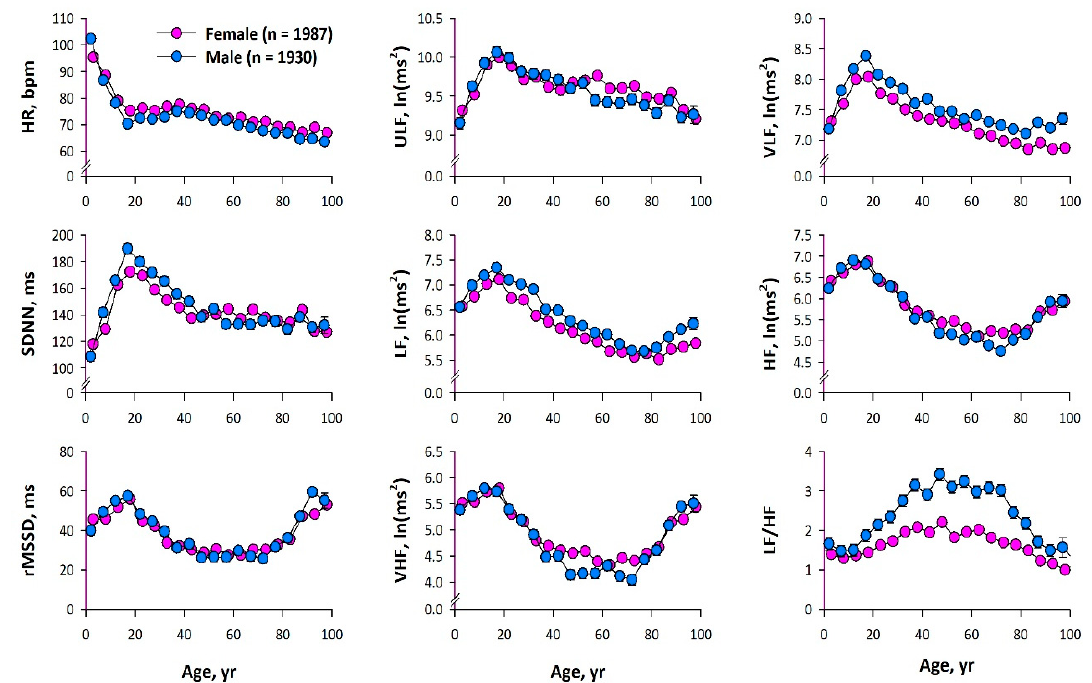
Figure 6. Age and sex dependency of the metrics of heart rate variability (HRV). HR = 24-h mean heart rate, SDNN = standard deviation of 24-h normal-to-normal R-R (NN) intervals, rMSSD = root mean square of successive difference in NN intervals, ULF = ultra-low frequency (<0.0033 Hz), VLF = very-low frequency (0.0033–0.04 Hz), LF = low frequency (0.04–0.15 Hz), HF = high frequency (0.15–0.4 Hz), VHF = very-high frequency (0.4–1.0 Hz), LF/HF = LF-to-LF ratio.